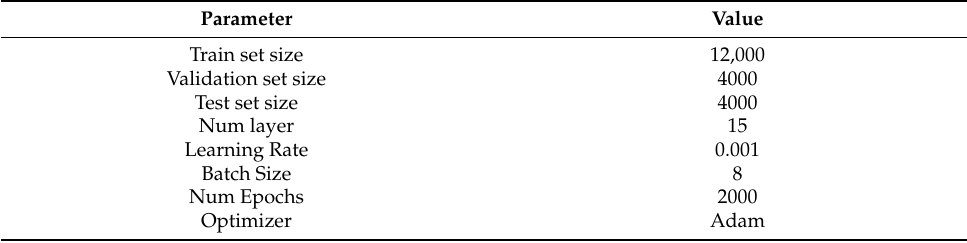
Table 6. Experimental Settings in NDR-Net